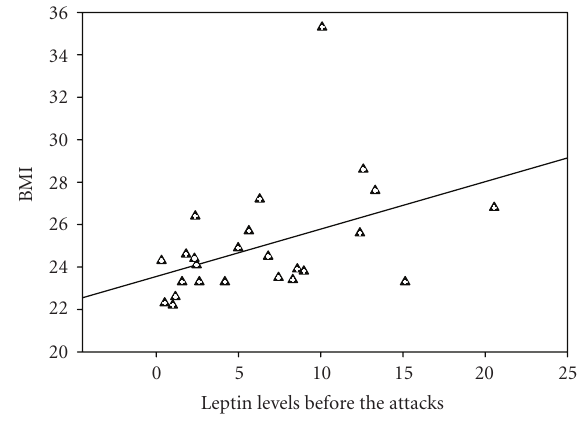
Figure 3: Correlation graph between BMI and preattack leptin lev- els in FMF patient ( r = 0 . 433, P < .